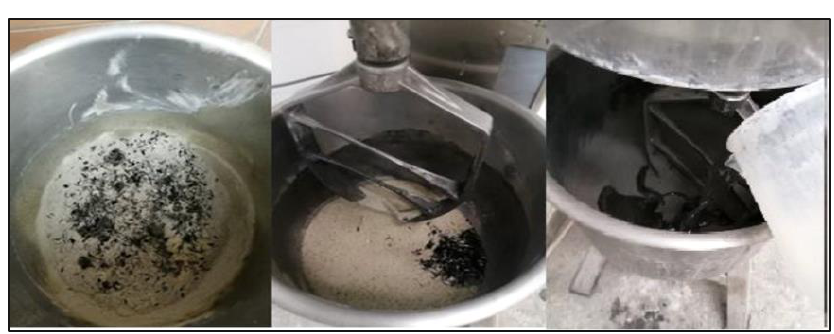
Figure 5. Adding short reinforcing fibers to the geopolymer mass.